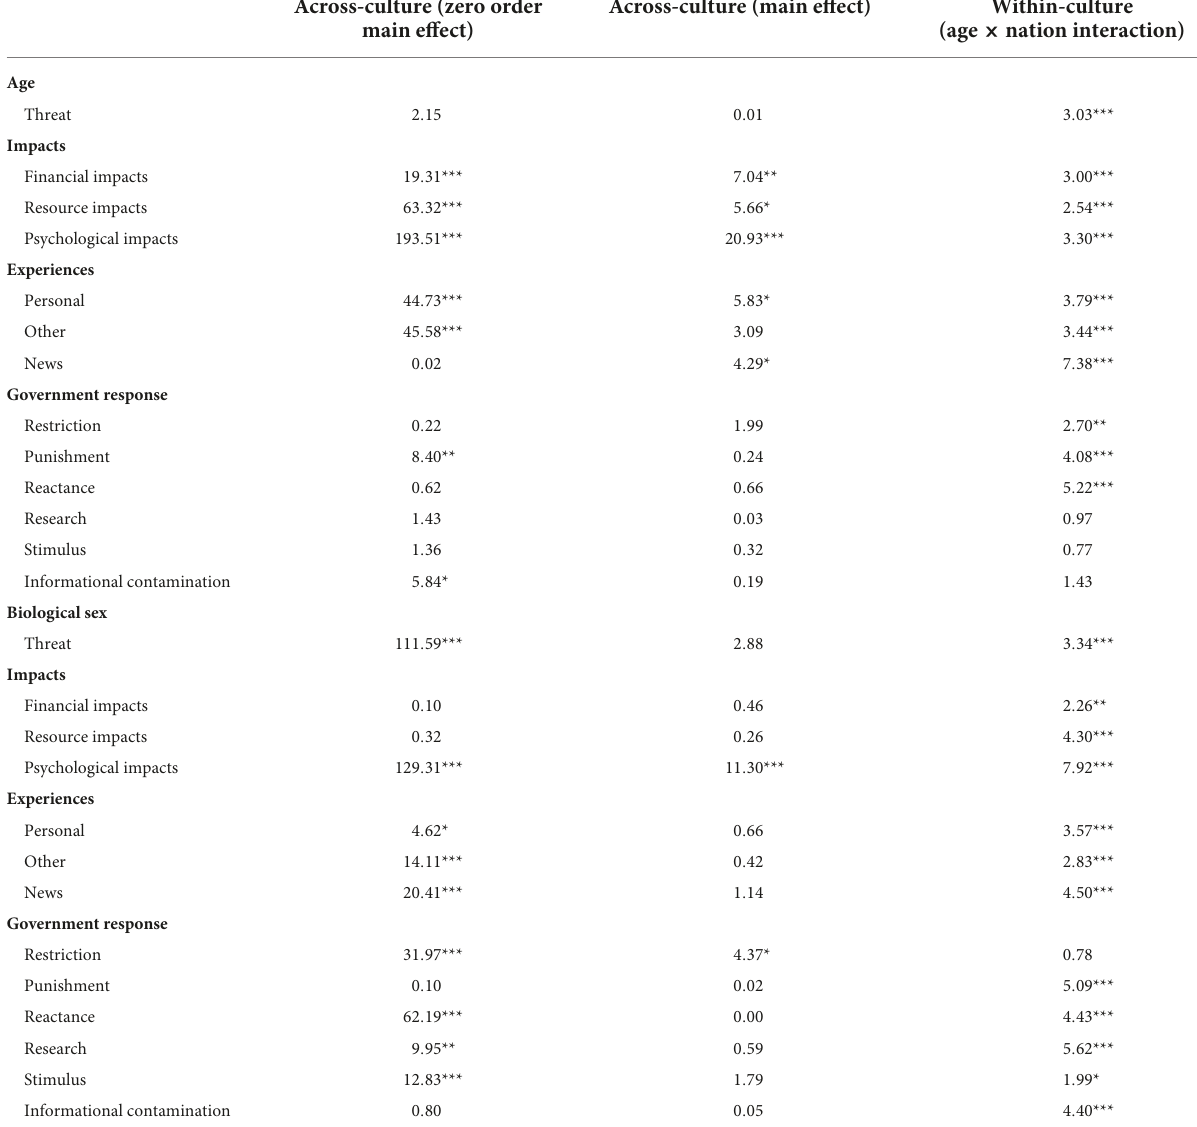
TABLE 7 Linear mixed models: comparing across-culture versus within-culture effects for age and biological sex. Across-culture (zero order Across-culture (main effect) Within-culture main effect) (age × nation